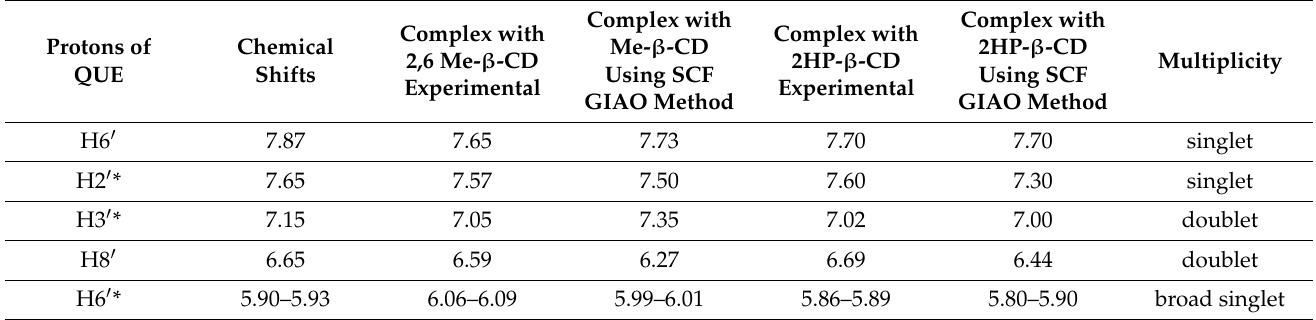
Table 5. 1 H NMR chemical shifts for QUE and its complexes with 2,6 Me- β -CD and 2HP- β -CD in D 2 O at 25 ◦ and chemical shifts obtained using the SCF GIAO